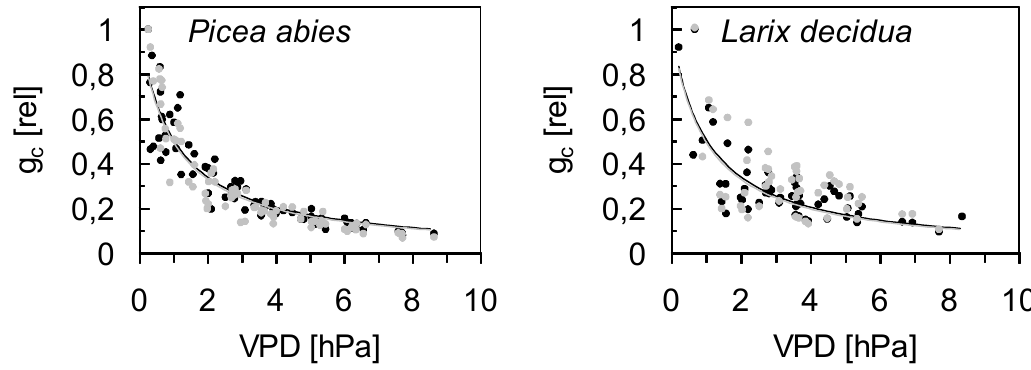
Figure 4. Daily mean normalized canopy conductance ( g c ) of Picea abies and Larix decidua saplings in the control (black) and rain exclusion treatment (grey) in relation to vapor pressure deficit obtained in 2017. Points are mean values of three saplings per treatment. Points were fit by Lohammer type equation: Picea abies : control: y = 1 / (1 + (VPD / 0.93)), R 2 = 0.83; rain exclusion: y = 1 / (1 + (VPD / 0.98), R 2 = 0.91 Larix decidua : control: y = 1 / (1 + (VPD / 0.94)), R 2 = 0.67; rain exclusion: y = 1 / (1 + (VPD / 0.94)), R 2 = 0.43. All p <